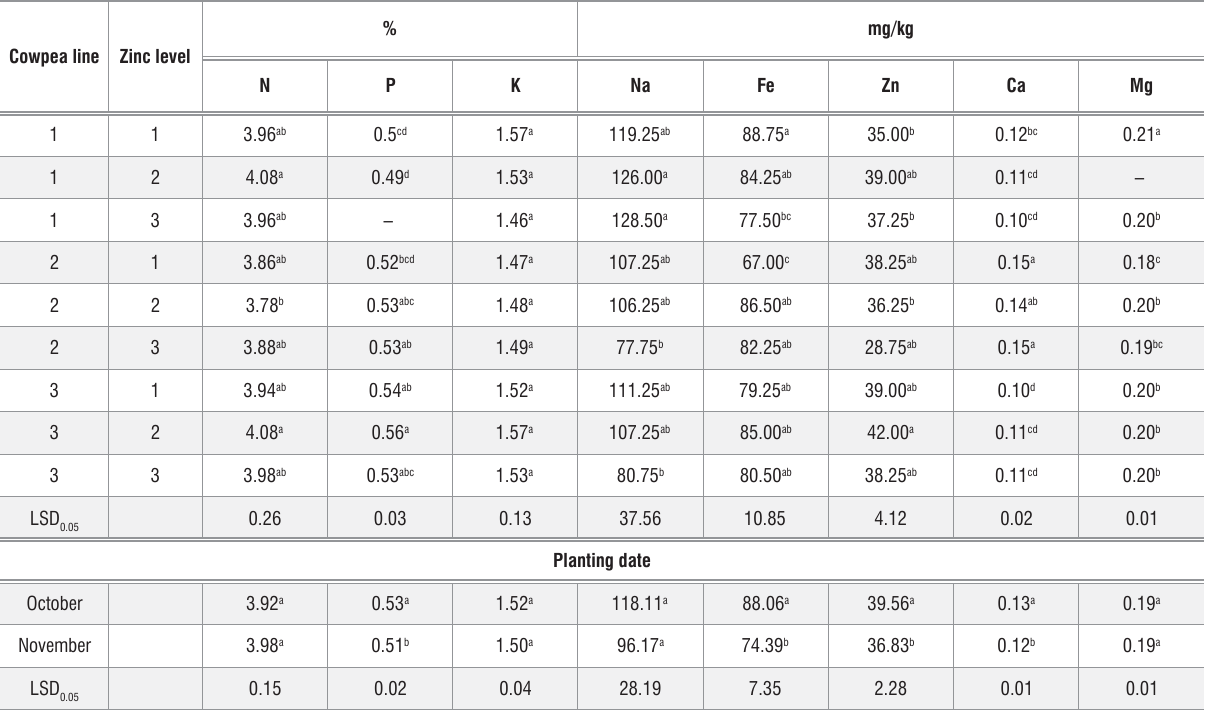
Table 6: Cowpea seed mineral content after zinc application at Bien Donne’